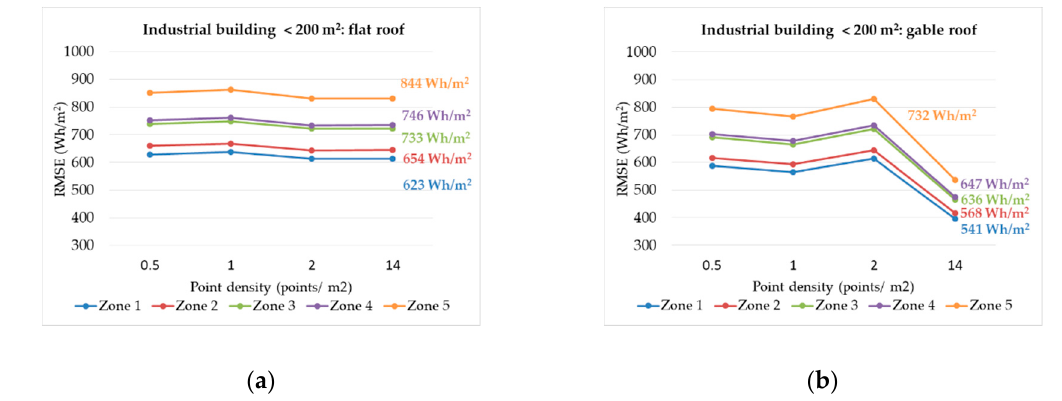
Figure 14. Average daily PV energy production per square meter loss (Wh/m 2 ) for industrial buildings with an area smaller than 200 m 2 : ( a ) flat roof, ( b ) gable roof.